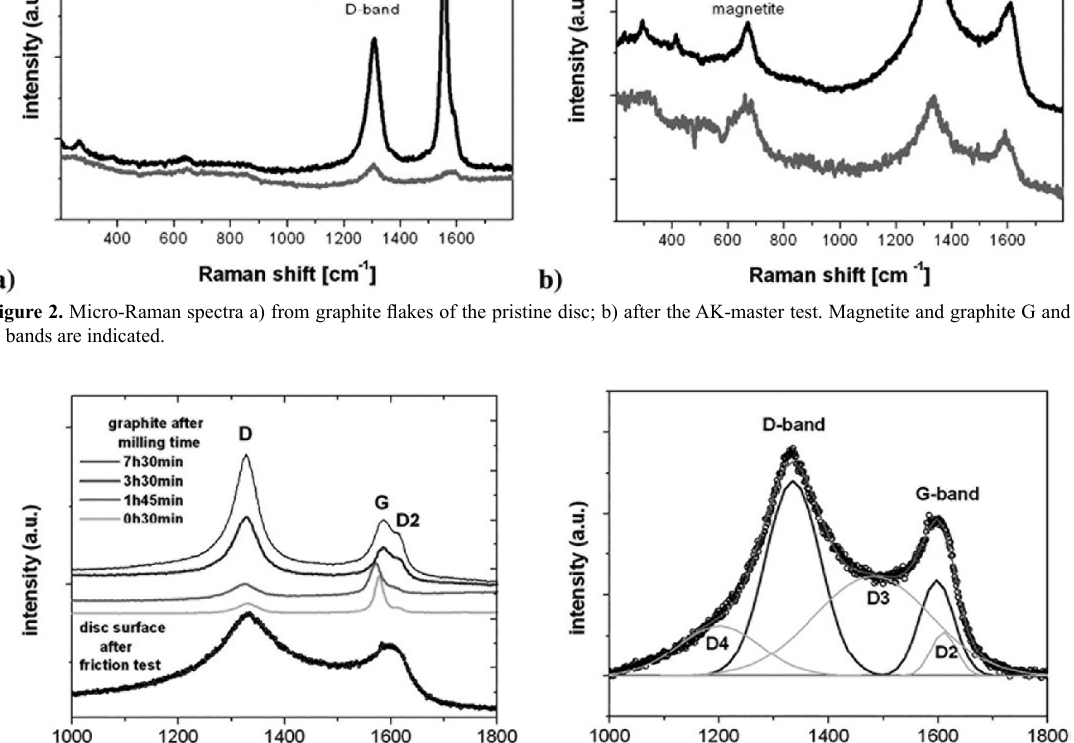
grains are anchored in a matrix, they cannot orient their basal planes parallel to the direction of shear stress, as e.g. in friction tests, where graphite powder is used as lubricant 21 . When the graphite crystals are immobilized and unable to